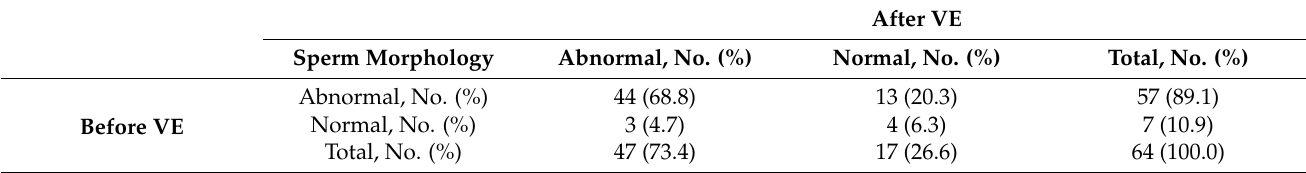
Table 8. Cross-tabulation table showing the number of patients with abnormal and normal sperm morphology in the first semen analysis before varicocele embolization (VE) versus in the second semen analysis after VE. After VE Sperm Morphology Abnormal, No. (%) Normal, No. (%) Total, No.